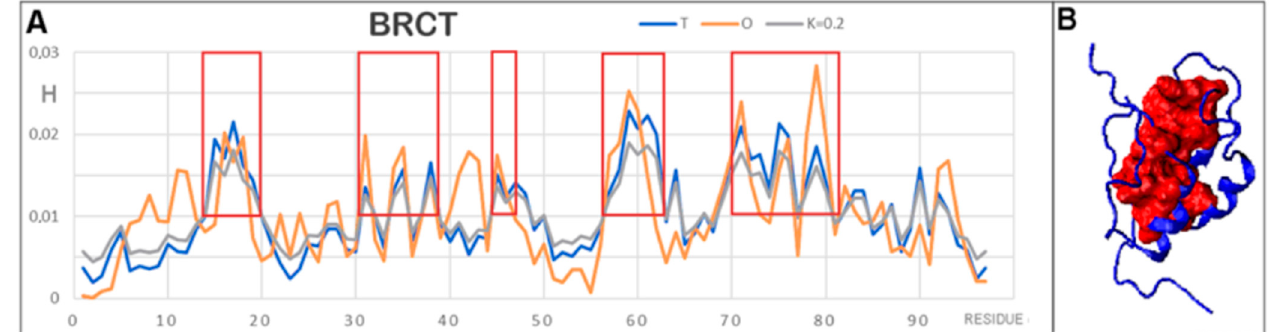
Figure 10. Characteristics of BRCT. ( A ) The T, O, and M profiles for BRCT show a high agreement of the distributions. The boxes distinguish the items constituting the components of the hydrophobic nucleus. These were determined using the criterion of high values of Ti and Oi. The frames distinguish sections that are part of the hydrophobic nucleus. ( B ) 3D structures of the BRCT protein (PDB ID 2L42) with the highlighted hydrophobic nucleus (red) according to the identification shown in ( A ).